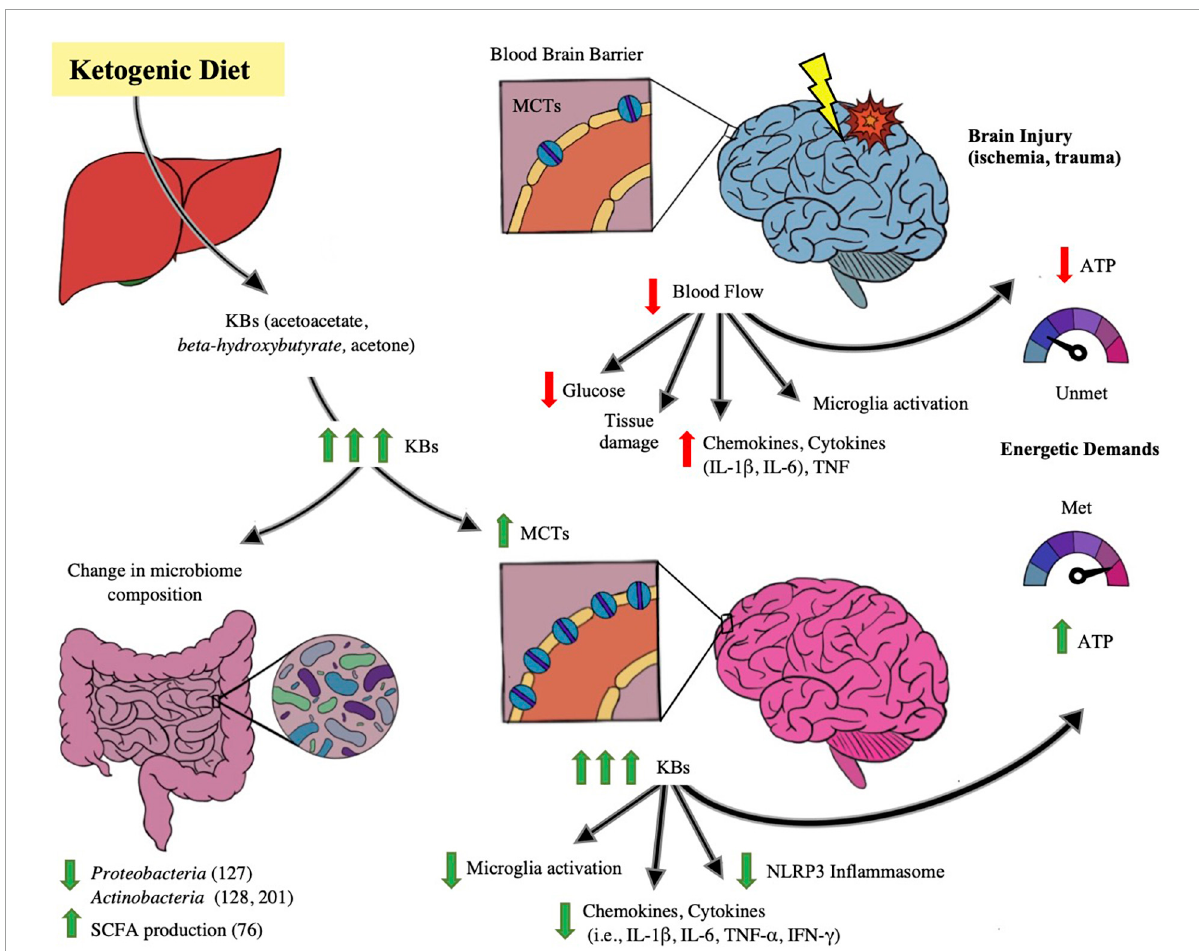
FIGURE2 Impact of ketogenic diet ameliorating abnormalities in microbiome-gut-brain axis. The figure illustrates the effect of the ketogenic diet (KD) on alleviating brain injury and modulating the microbiome. With ischemic and traumatic acute brain injury, the energetic demands of the brain